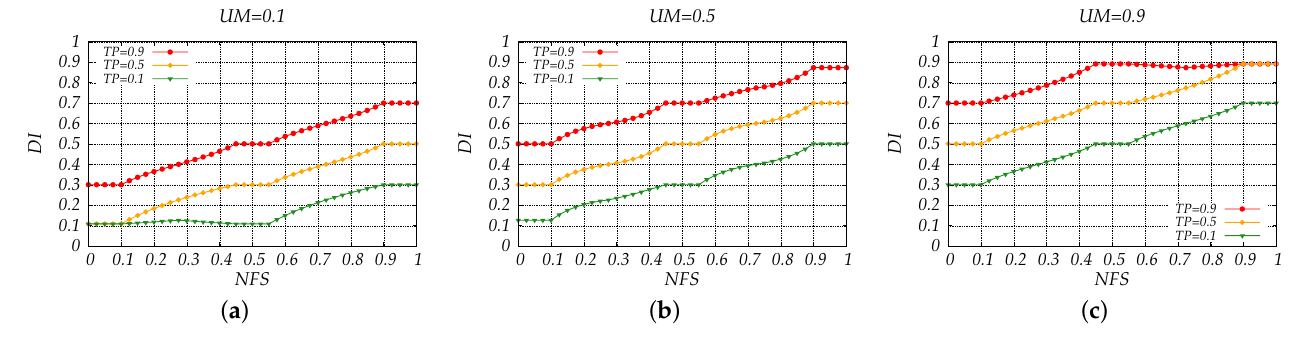
Figure 5. Simulation results showing the effect of UM, TP, and NFS on the determination of DI. ( a ) UM = 0.1, ( b ) UM = 0.5, ( c ) UM =